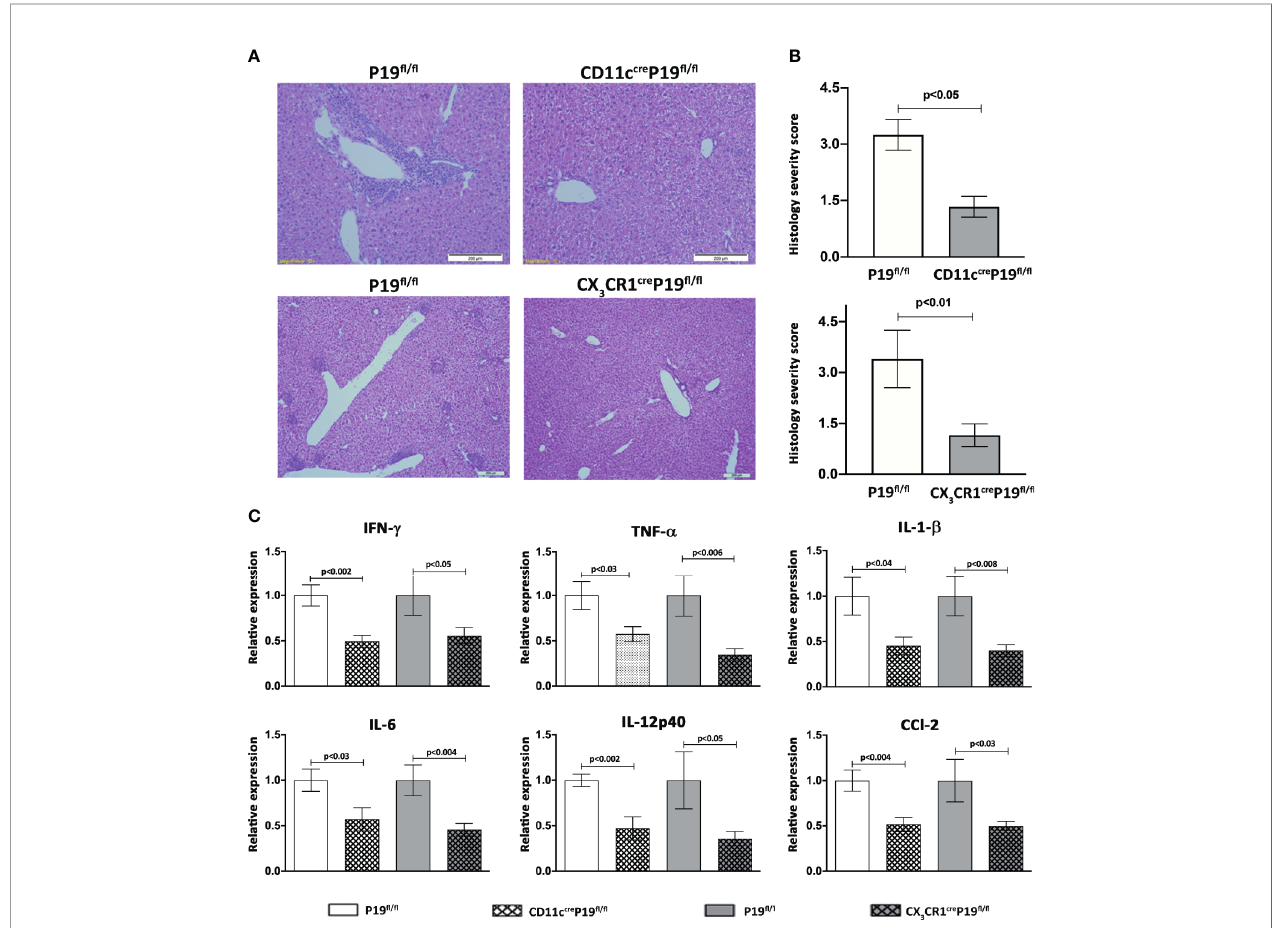
FIGURE 3 | MNPs-restricted IL-23 de fi cient mice display attenuated disease severity in the 2OA-BSA autoimmune cholangitis model. MNPs-restricted IL-23 de fi cient and littermate controls mice were immunized with 2OA-BSA. Disease severity was evaluated 8 weeks following immunization by histological assessment of liver sections stained for hematoxylin &eosin, original magni fi cation 40X (A) , accompanied by graphical summary of histological severity score (B) . Graphical summary depicting expression levels of hepatic cytokines of indicated mice (C) . All data presented as mean ± SEM (n ≥ 10) for each group. Results are representative of two independent experiments. p values < 0.05 were considered as signi fi cant (unpaired Student ’ s